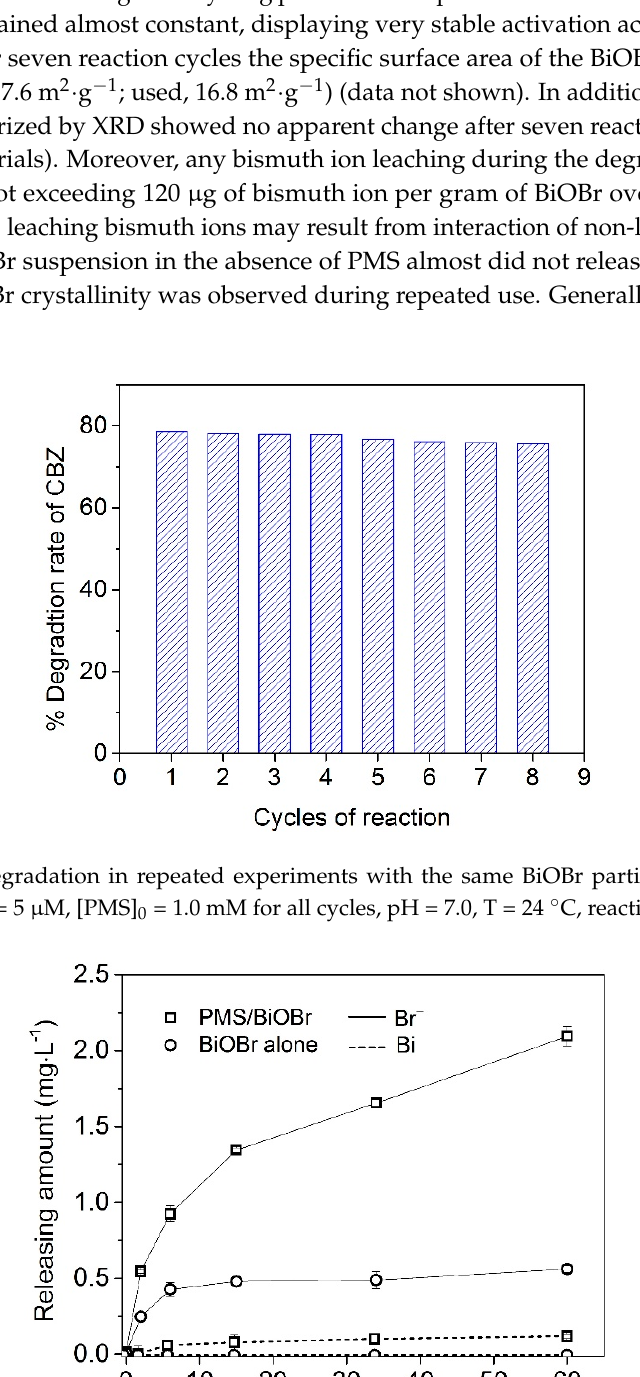
Figure 2. The effects of water matrix on the degradation performance of CBZ. BiOBr dose 0.5 g ∙ L − 1 , [CBZ] 0 = 5 μ M, [PMS] 0 = 4.0 mM, T = 24 °C .